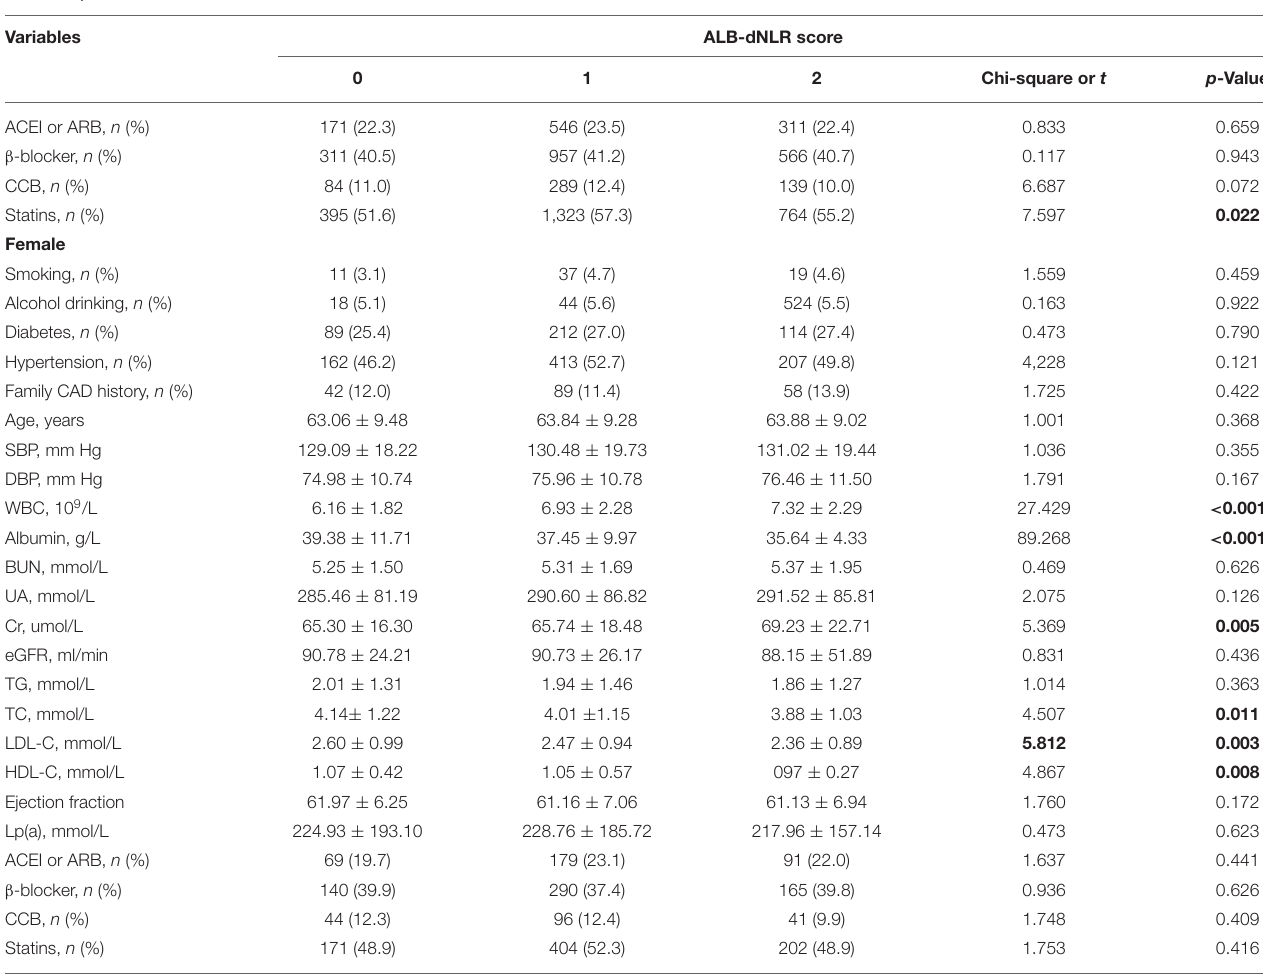
were also significantly different among the three groups. Other baseline data did not differ (all P > 0.05). As shown in Table 2 , the characteristics of chronic total occlusion (CTO) ( P = 0.046), multivessel lesions (MLs) ( P = 0.020) and the number of lesional vessels ( P = 0.019) differed significantly among the three groups.